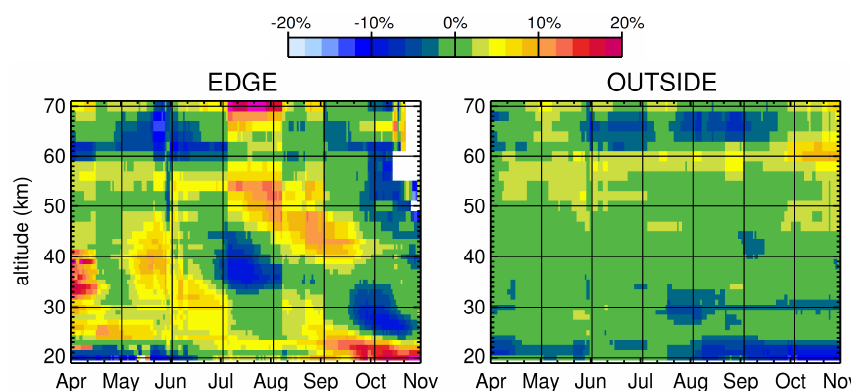
Figure 2. Example of the O 3 amplitude (see Sect. 3.1.1 for definition) observed by MIPAS from 2002 to 2011 between years of high Ap index and years of low Ap index centred around 1 April, for the regions EDGE (left) and OUTSIDE